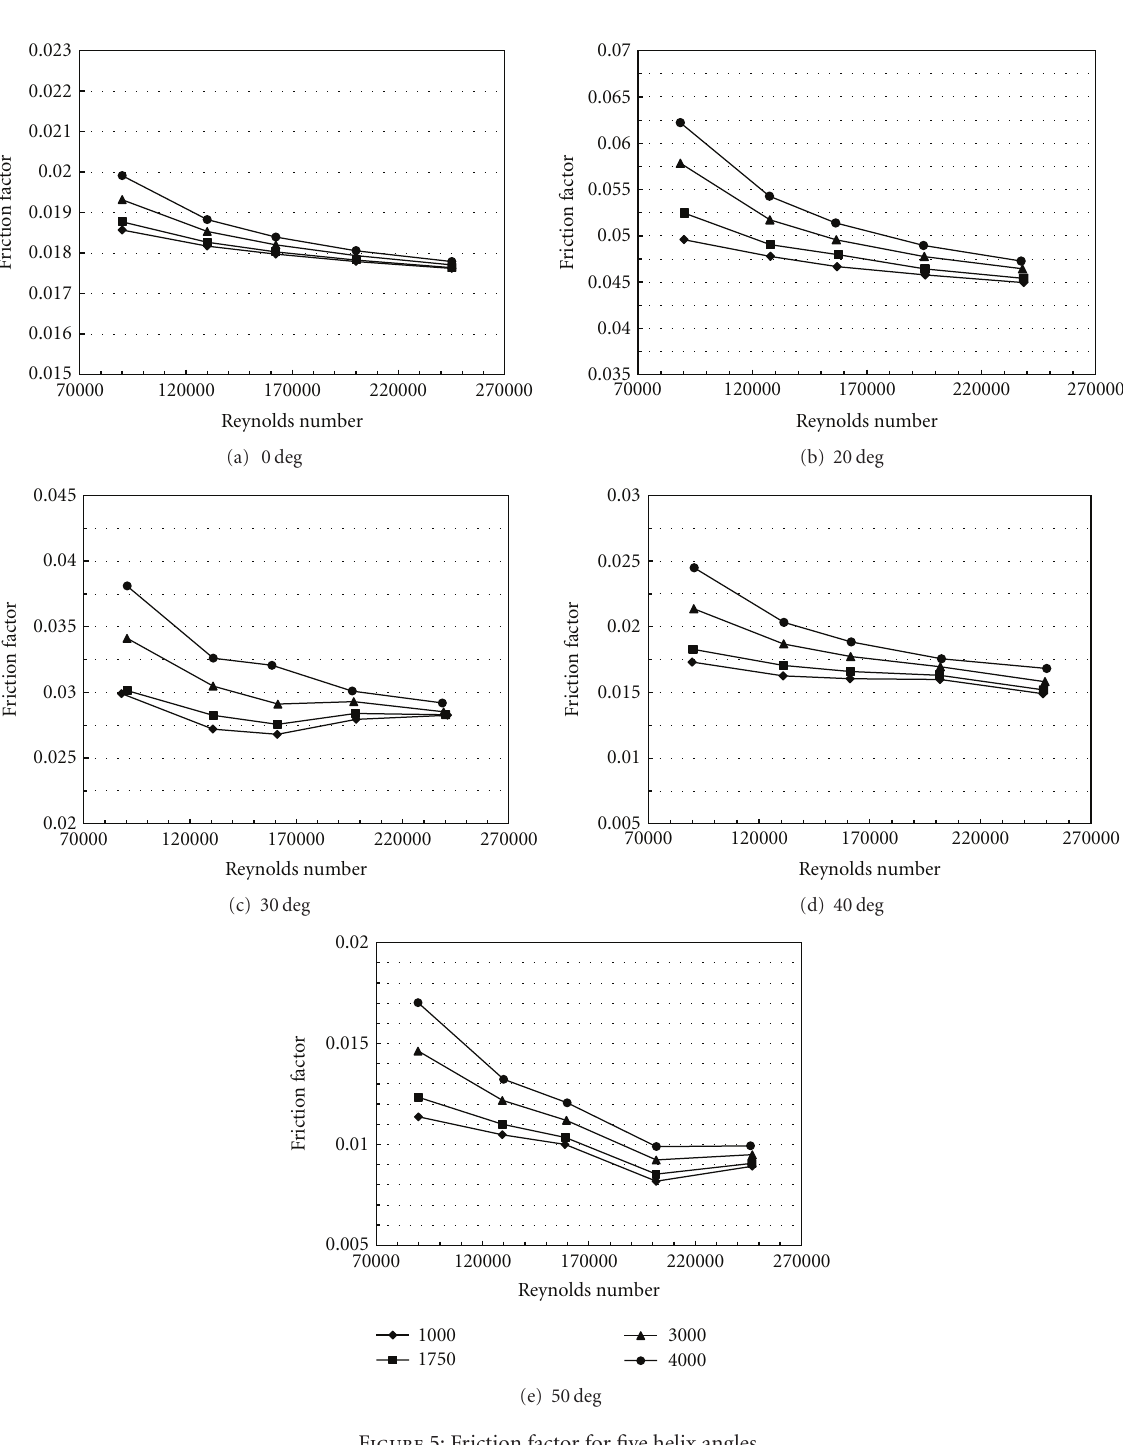
Figure 5: Friction factor for five helix